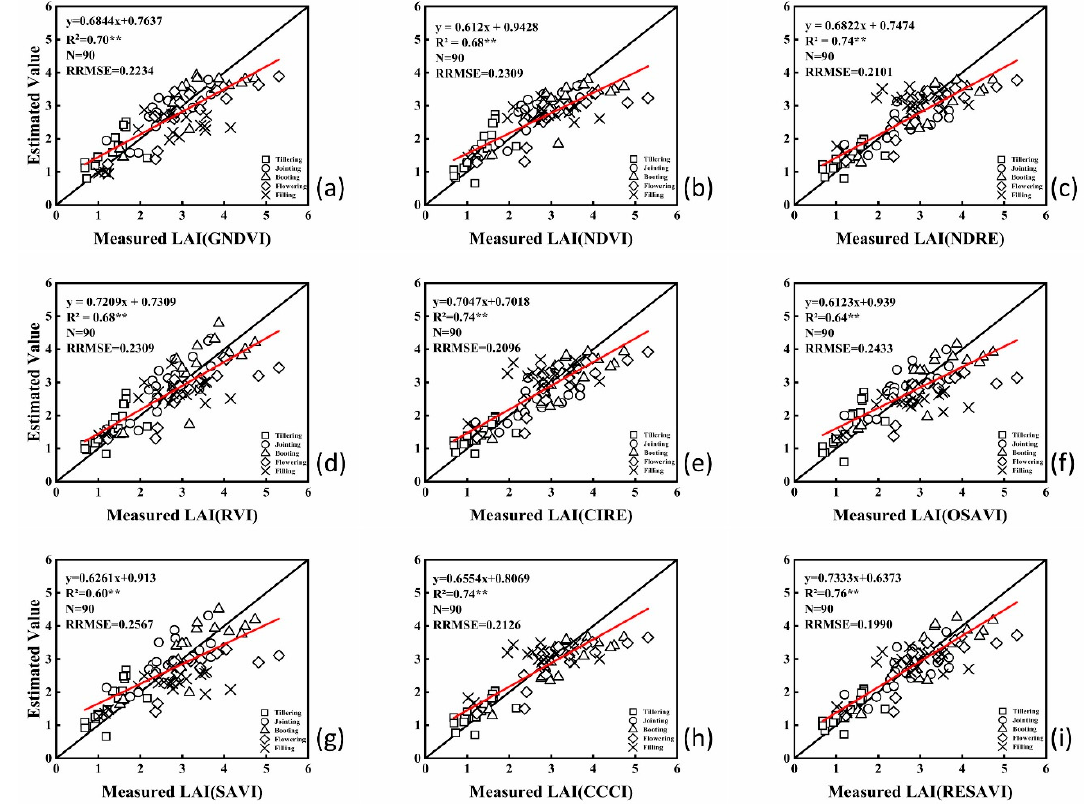
Figure 5. Validation of leaf area index (LAI) estimation models for the entire growth season of wheat: ( a ) GNDVI; ( b ) NDVI; ( c ) NDRE; ( d ) RVI; ( e ) CIRE; ( f ) OSAVI; ( g ) SAVI; ( h ) CCCI; ( i ) RESAVI.